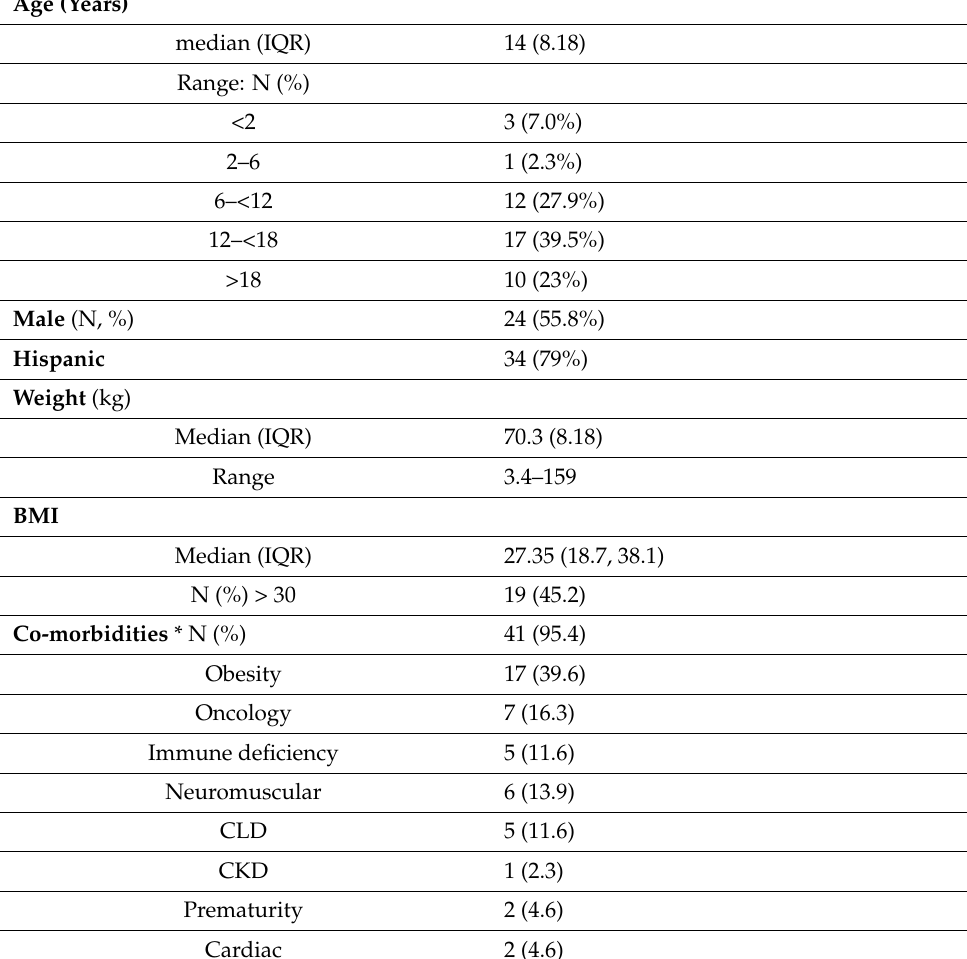
Table 1. Demographic (N =